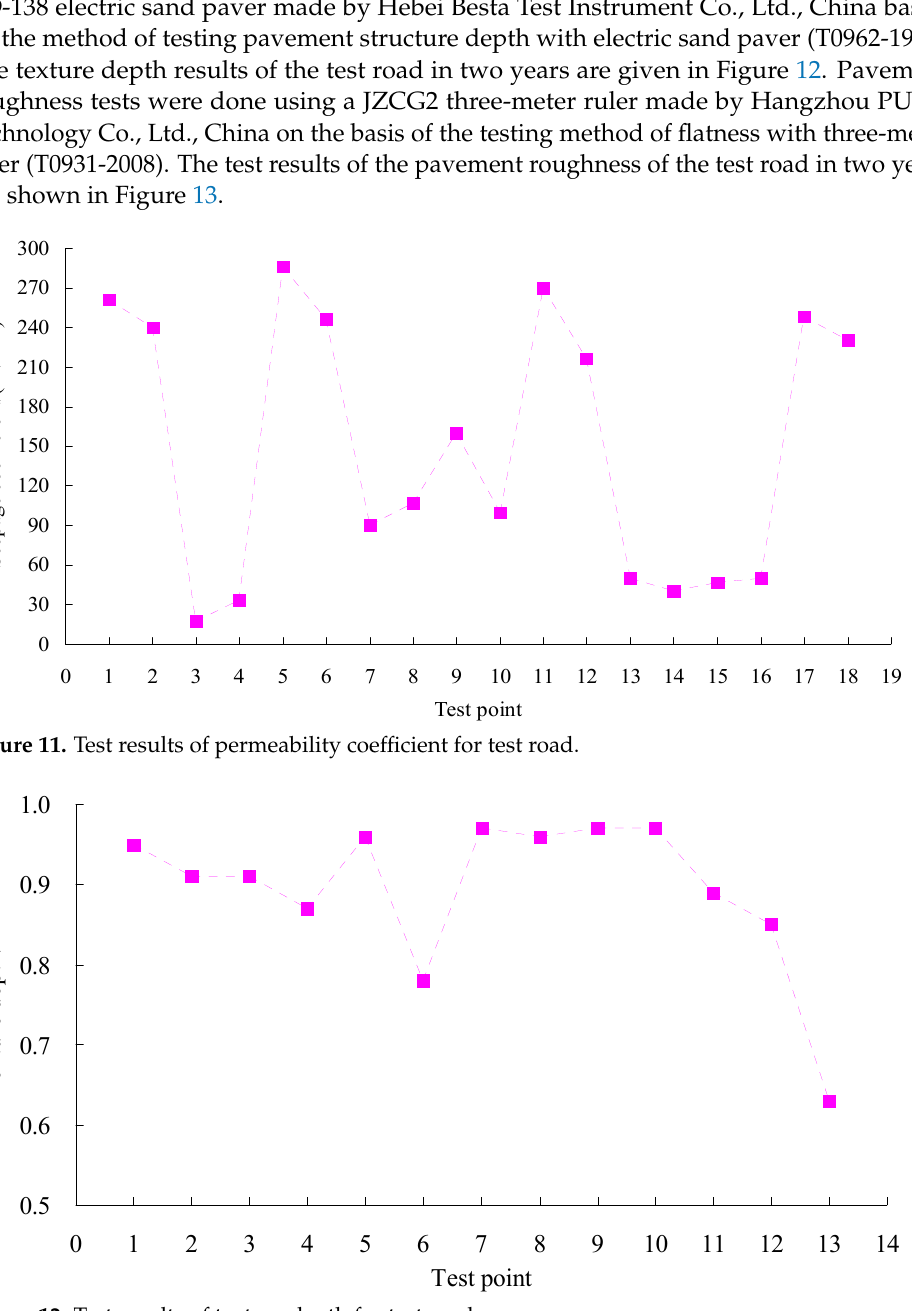
Figure 12. Test results of texture depth for test road.